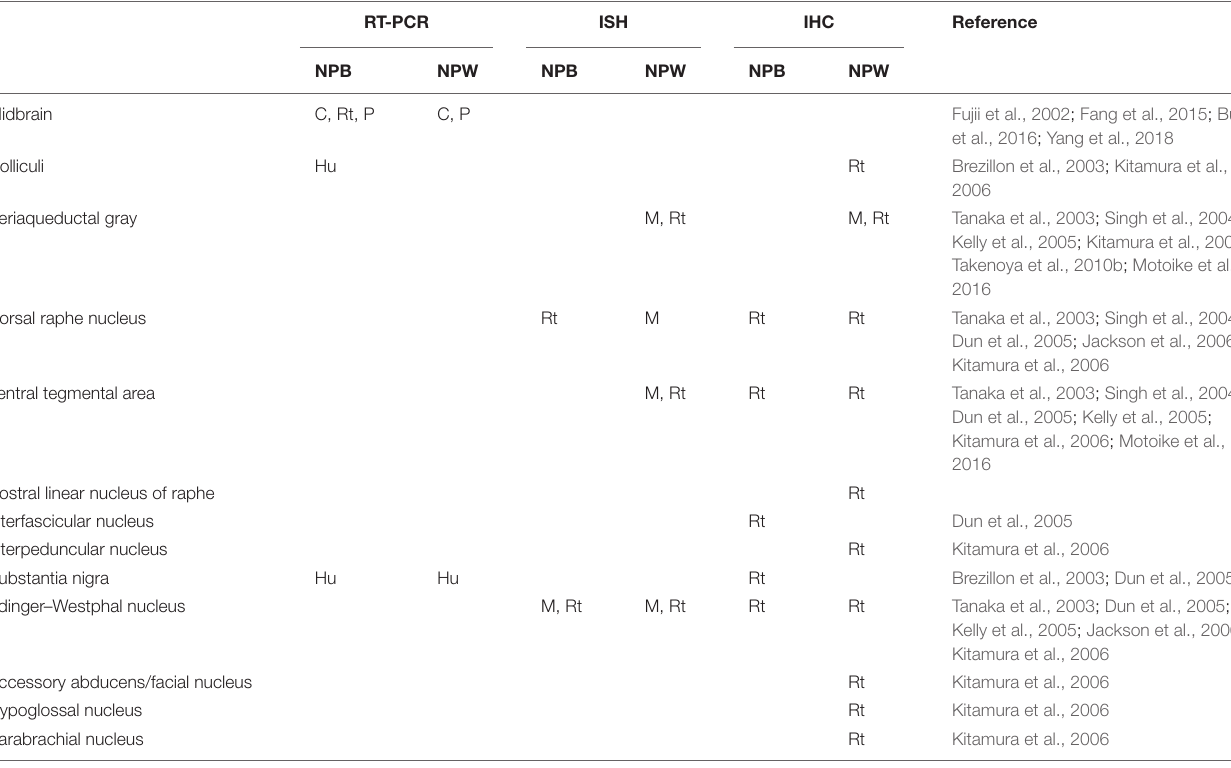
TABLE 3 | Localization of NPB and NPW in the midbrain.